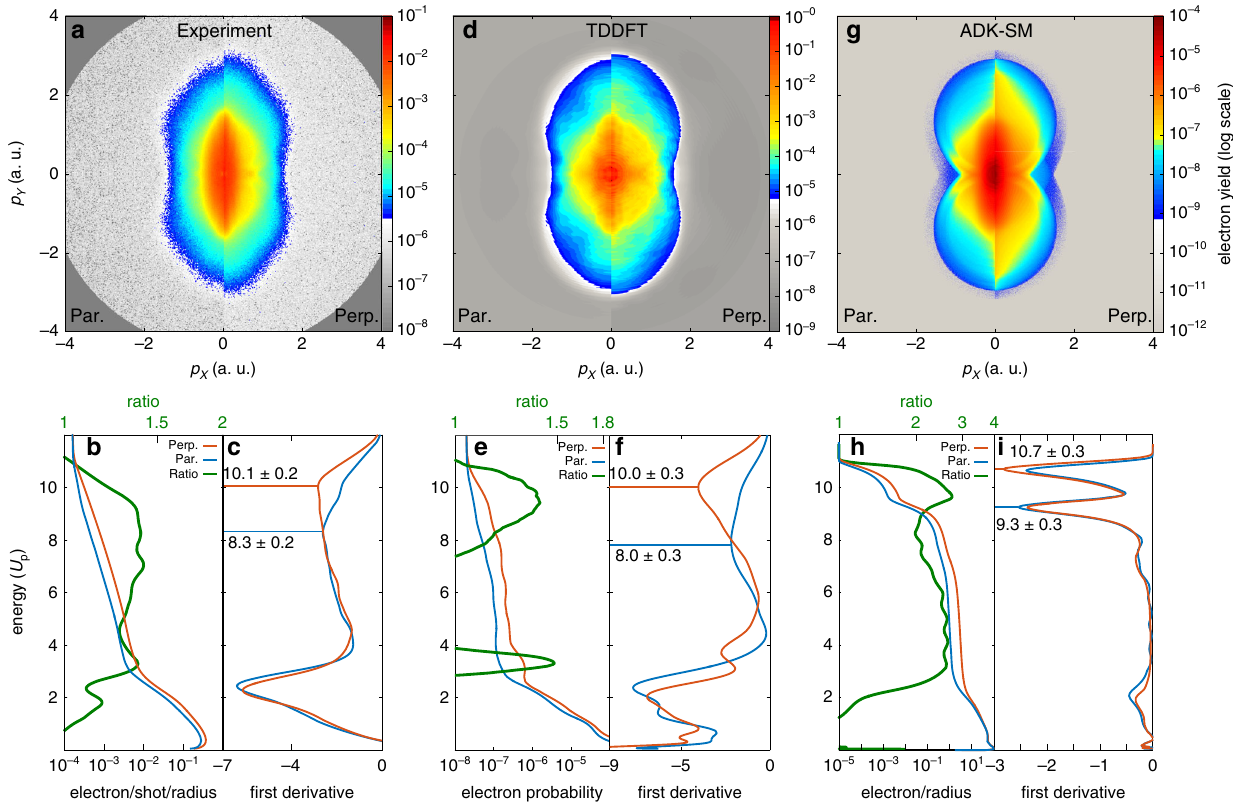
Fig. 2 Molecular-frame angle-resolved photoelectron spectra of OCS. These data were obtained a – c experimentally and computationally from d – f TDDFT and g – i ADK-SM calculations. a , d , g Split graphical representation as a comparison of the photoelectron distributions for parallel and perpendicular alignment for the experimental and computational results, respectively. b , e , h Corresponding projected energy distributions of photoelectrons along the Y axis, angularly integrated within a cone of ±20°, as well as the ratio of the integral-normalised perpendicular and parallel distributions, on logarithmic scales. Energies are reported in units of the ponderomotive energy U p . c , f , i First derivatives of the photoelectron-energy distributions to evaluate the high- energy cut-off for the two molecular-alignment cases. All TDDFT computational results were obtained by averaging over different laser-molecule orientations according to the experimental alignment distributions and by adding a constant to account for the experimental background level. The ADK- SM results refer to a single laser intensity and perfect alignment for both cases. See Supplementary Note 2 for